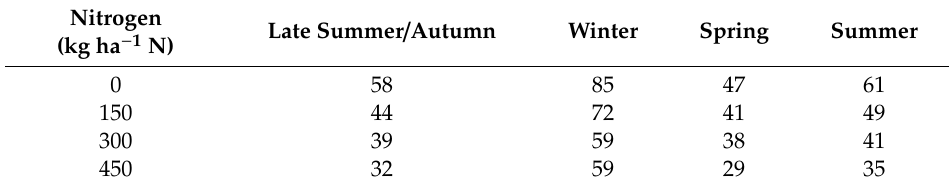
Table 3. Average grazing interval (days) of grass pastures Brachiaria brizantha cv. Piat ã under rotational stocking and fertilized with nitrogen throughout seasons of the year.